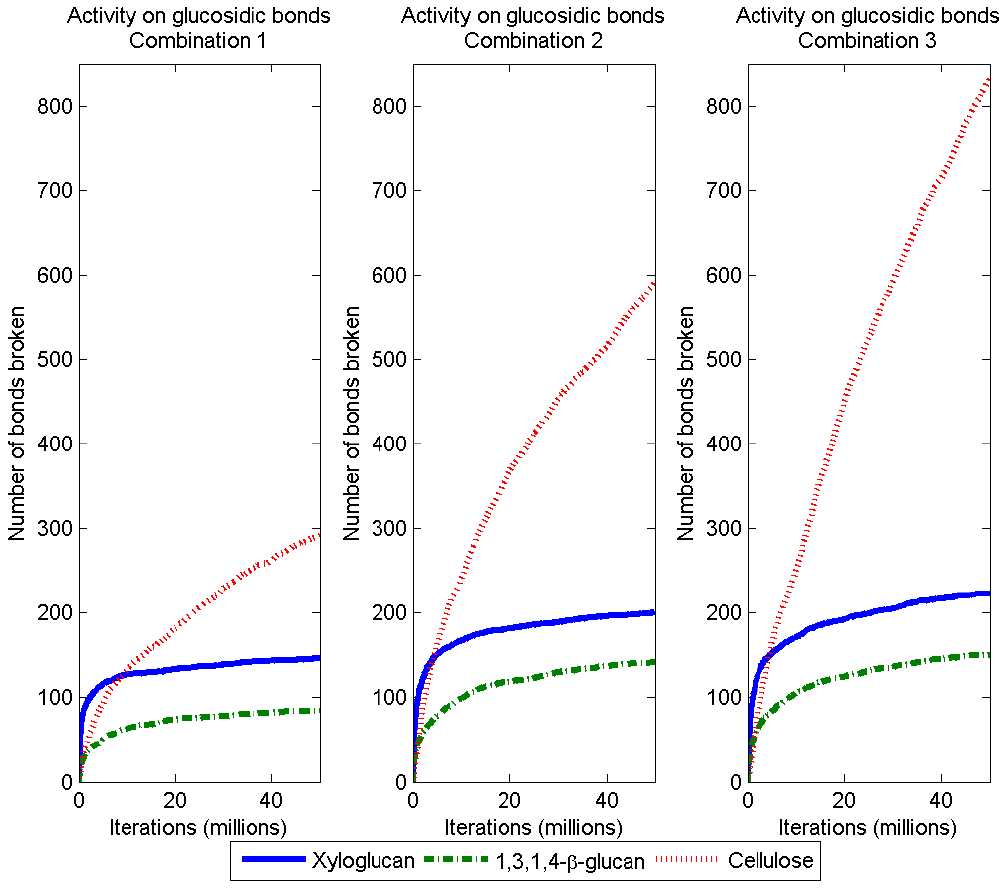
Figure 7. Simulation results for cumulative enzyme activities on glucosidic bonds versus simulation progress (in iterations), for three enzyme combinations (with constant number of catalytic domains targeting glucosidic bonds). Synergies were evident between Cel51A and Cel9D, and Cel51A, Cel9D and endoxylanase 1. Combination 1: 40 Cel51A (endoglucanase) enzymes; Combination 2: 20 Cel51A (endoglucanase) and 20 Cel9D (exoglucanase) enzymes; Combination 3: 20 Cel51A (endoglucanase) and 20 Cel9D (exoglucanase) and 20 endoxylanase 1 (endoxylanase with α -arabinofuranosidase activity)